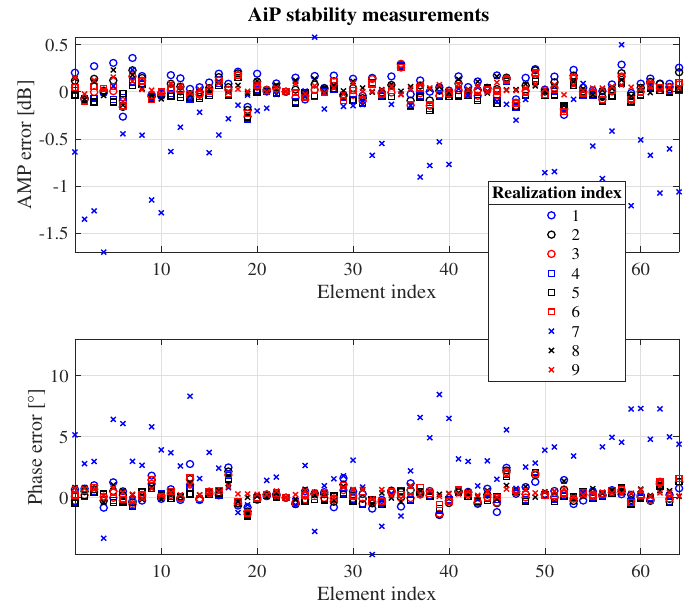
Figure 4. AiP elements stability measurement